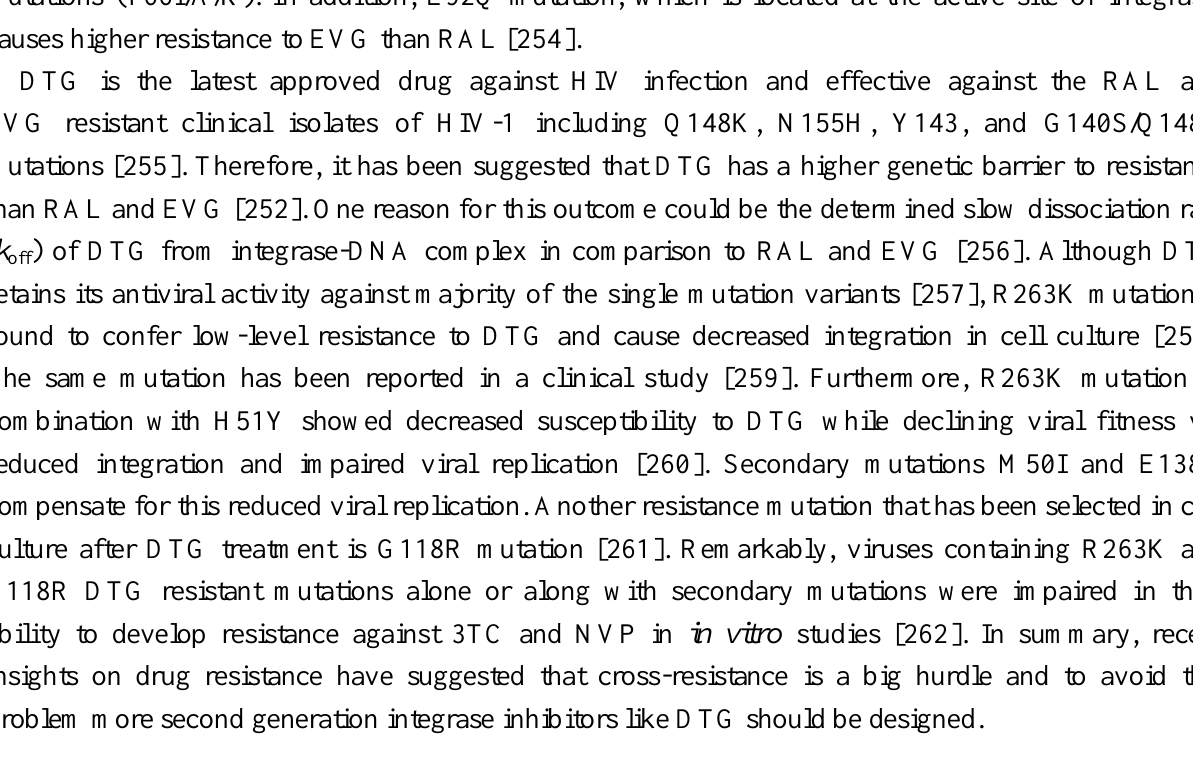
Table 5. Major Integrase Inhibitor Resistance